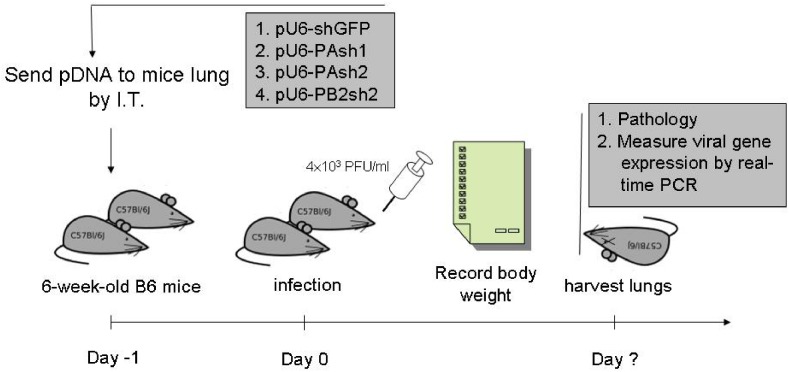
Timeline for studying the shRNA intratracheal delivery model in mice.shRNA plasmids were mixed with jetPEI with a N/P ratio of 5. Twenty micrograms of plasmids in 50 μL of carrier were administered intratracheally through a 2.5-mm human otoscope specula placed directly into the trachea. The mice were inoculated with 4×103 PFU/mL influenza virus 24 hours after shRNA transfection. The body weights of the mice were recorded daily, and the lungs were harvested at the time of death or upon euthanasia at day 14. I.T.: intratracheal.